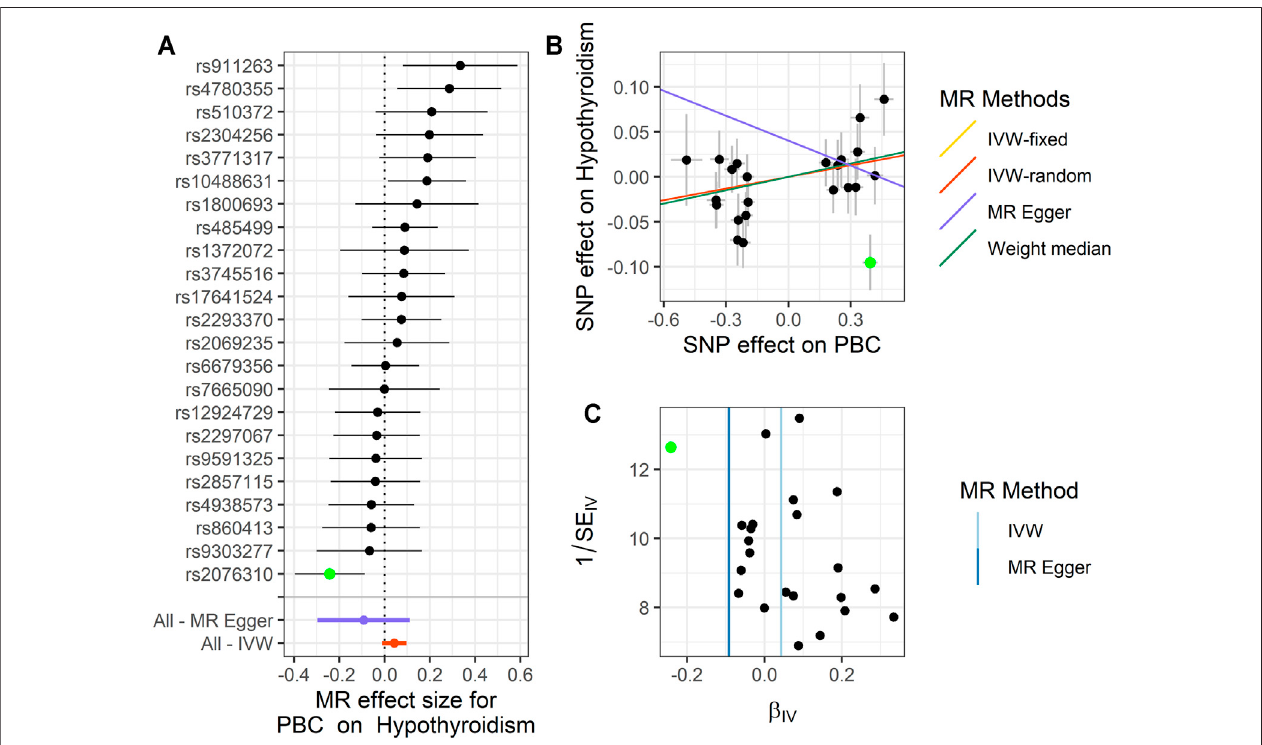
FIGURE4| SummaryoftheMRanalysisforPBConhypothyroidism. (A) MReffectsizeofeachIV,MR-Egger,andIVW. (B) ThescatterplotofcausaleffectsofPBC on hypothyroidism. We use vertical and horizontal black lines to show 95% CI of the estimated effect of IVs on PBC (x-axis) and that on hypothyroidism (y-axis), respectively.WeusetheredlinetoshowtheIVWrandom-effectsmodel.ThepotentialSNPoutliers(rs2076310)arehighlightedingreen. (C) Thefunnelplotofthecausal effect of PBC on hypothyroidism. Each point represents the estimated causal effect of each IV. The vertical dark blue line represents the causal effect estimate obtained using the MR-Egger method; the light blue line represents the causal effect estimate obtained using the IVW method. The potential outliers (rs2076310) are highlighted in green. MR, Mendelian randomization; PBC, primary biliary cholangitis; IV, instrumental variable; IVW, inverse variance weighting; SNP, single-nucleotide